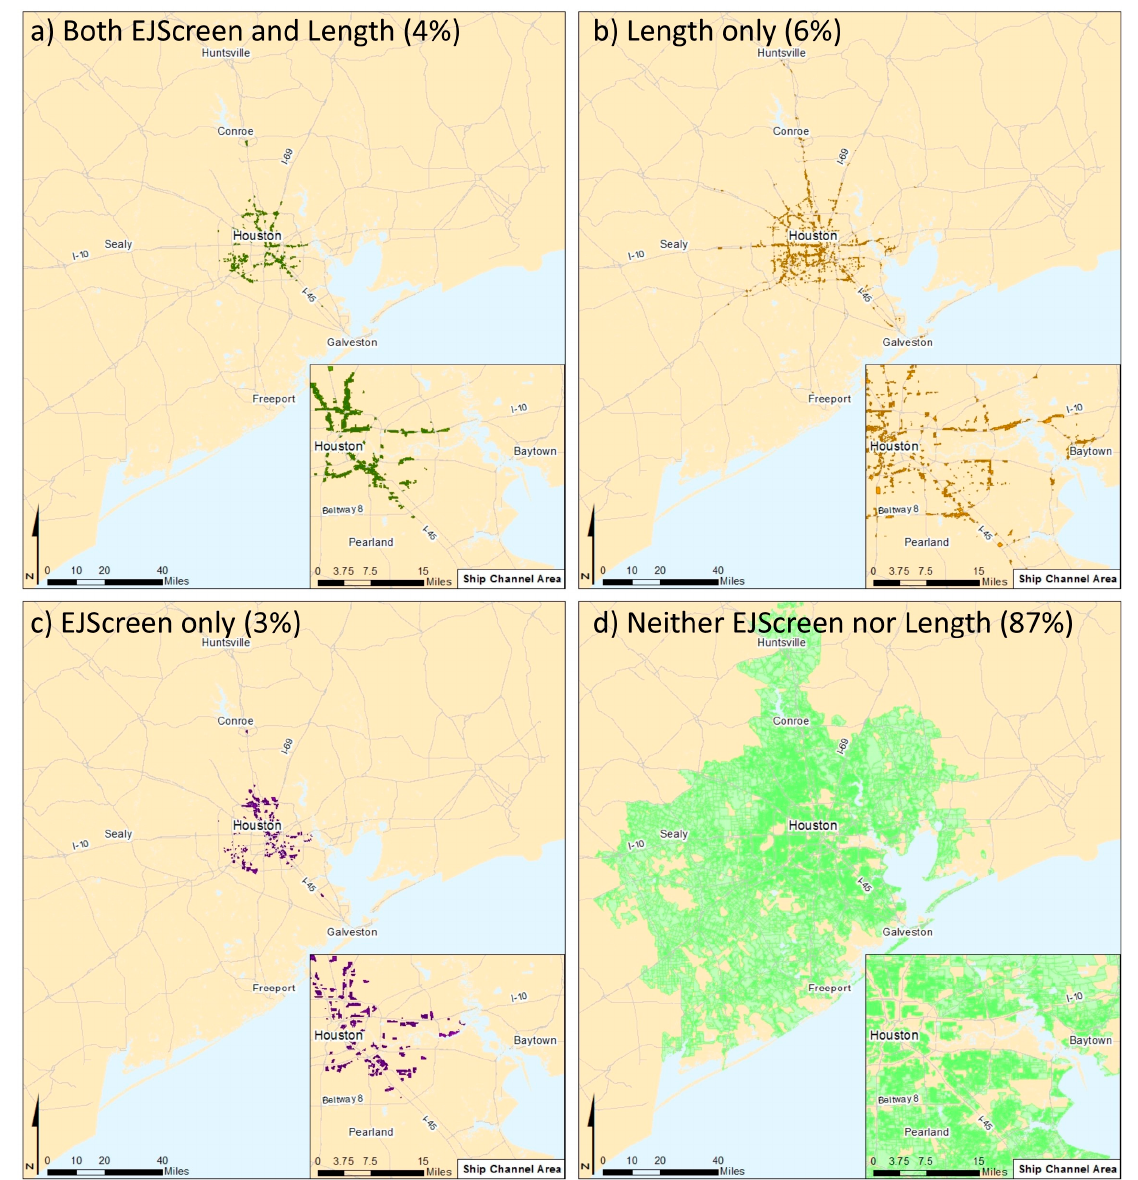
Figure 7. Comparison of areas where environmental justice concerns are elevated, identified as populated blocks with environmental justice (EJ) index values that are above the 90th percentile for the region. Areas of concern that are identified using both the EJScreen and Length methods are shown. Part ( a ) shows areas of elevated concern indicated by both methods, part ( b ) shows areas of elevated concern indicated by the Length method only, part ( c ) shows areas of elevated concern indicated by EJScreen only, and part ( d ) shows areas that are not identified using either method (populated blocks with EJ index values that are below the 90th percentile).